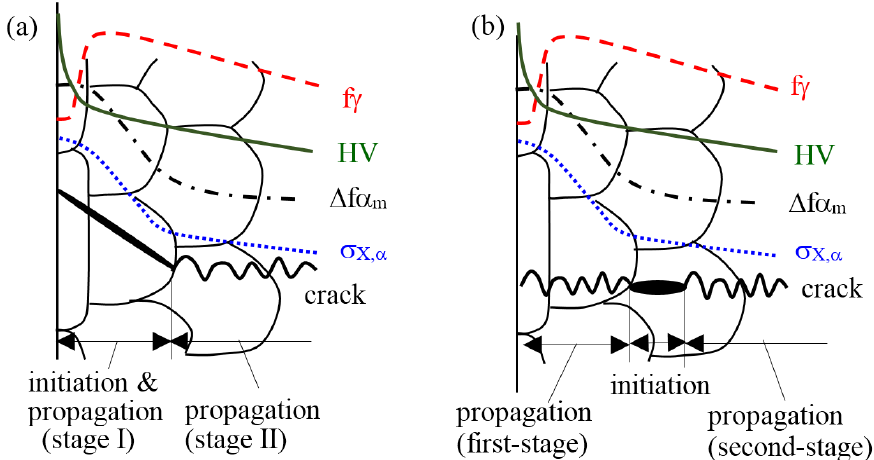
Figure 10. Crack initiation origins and the distribution of surface-hardened layer properties in TM steel subjected to vacuum carburization and subsequent fine particle peening. ( a ) surface crack, ( b ) fish-eye crack. HV: Vickers hardness, σ X, α : residual stress in α -bcc phase, f γ : volume fraction of untransformed retained austenite, ∆ f α m : volume fraction of strain-induced martensite.